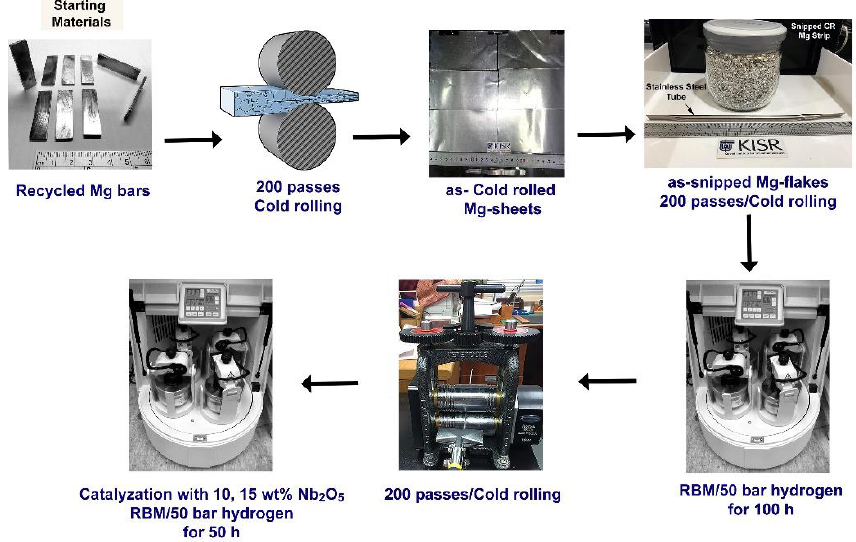
Figure 1. Flowchart diagram illustrating the multipreparation steps used to prepare nanocomposite MgH 2 /Nb 2 O 5 powders.